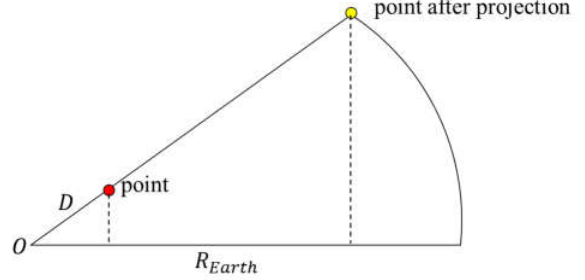
Figure 6 Satellite images of The Lama Temple and its surrounding environment